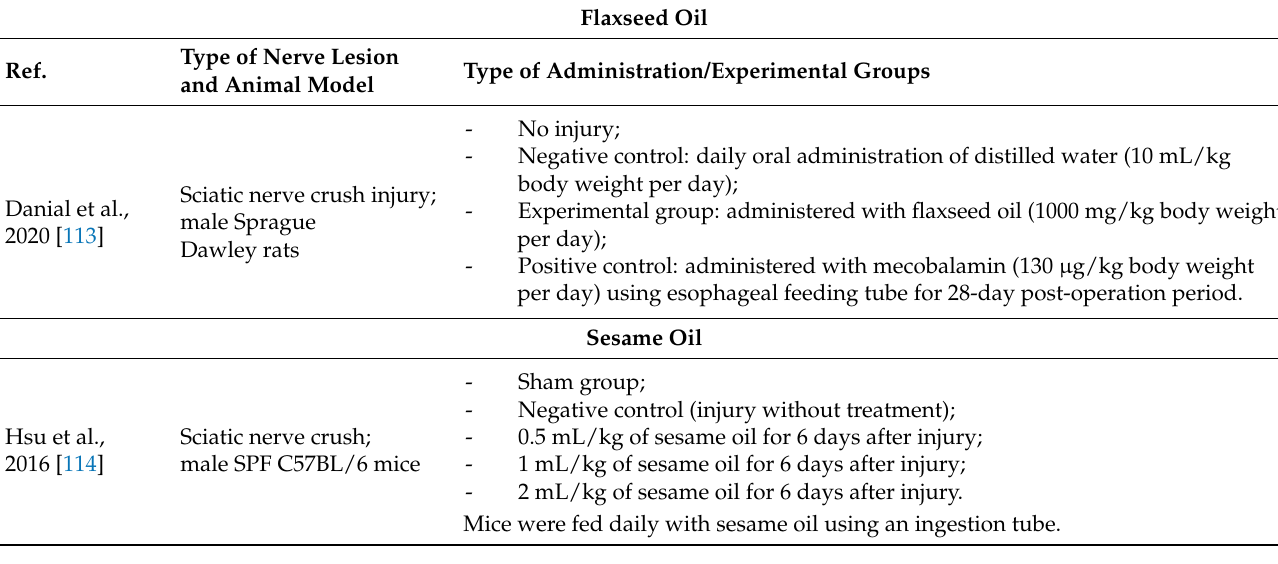
Table 7. Lignans: Table showing the experimental method (type of nerve injury and animal model), the dose, and method of administration of flaxseed oil and sesame